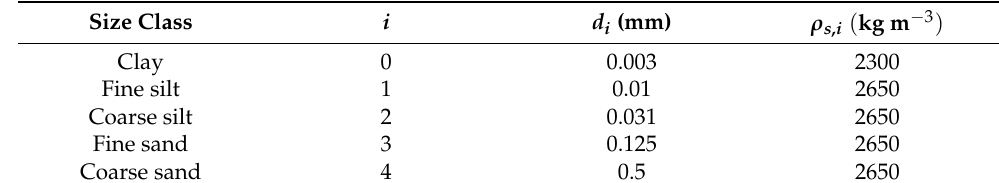
Table 1. Parameters of the sediment fractions. Size Class